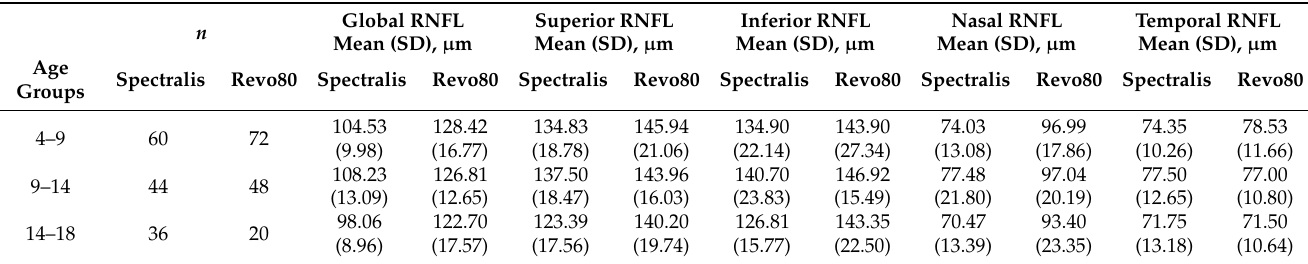
Figure 4. Scatterplot of global RNFL ( A ) and superior sector RNFL ( B ) thickness as a function of age of the subjects on Spectralis measurements. Table 6. Age group means for Global and Sectorial RNFL